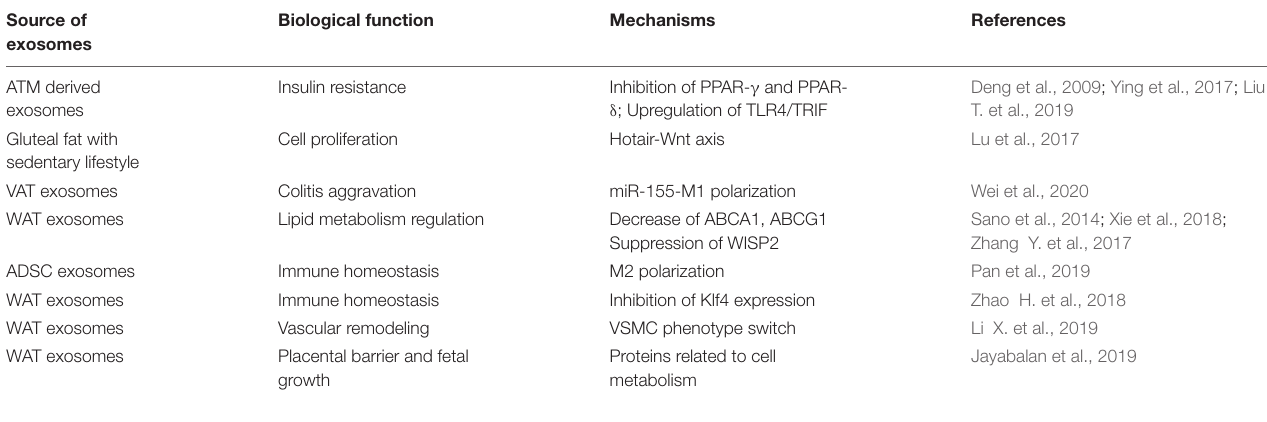
TABLE 1 | Adipose tissue-derived exosomes in the regulation of biological